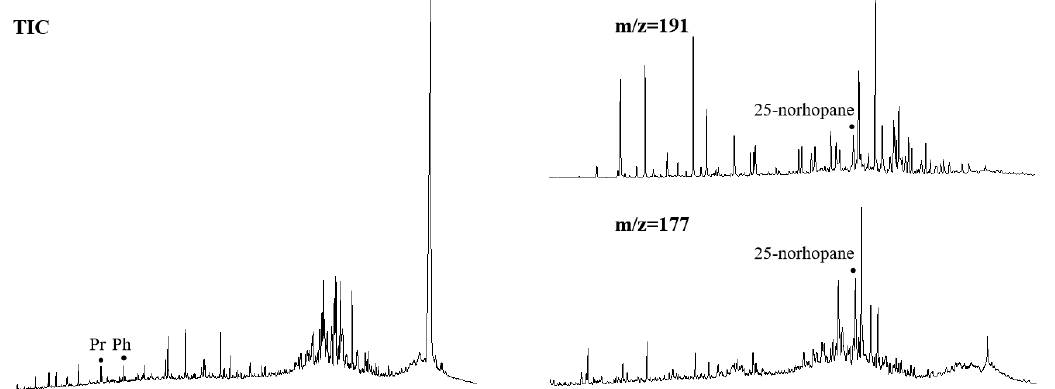
Figure 9. Total ion chromatograms (TIC) and Mass chromatogram of hopane of Jurassic heavy oil samples in Wuerhe area, showing the “baseline bulge” and high content of 25-norhopane.